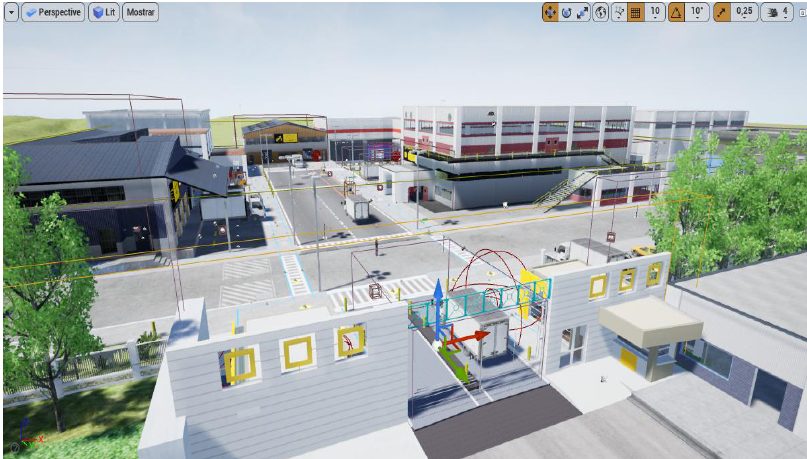
Figure 4. Manufacturing the plant case study — digital factory metaverse.